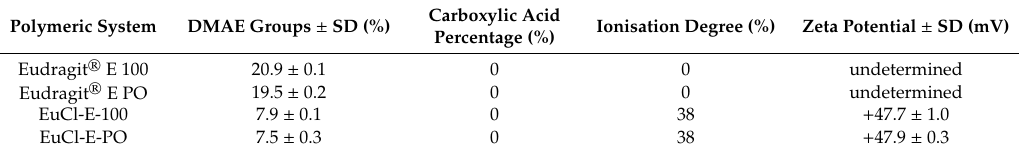
Table 1. Ionisation degree obtained for the polymeric materials derived from Eudragit E-100. Carboxylic Acid Polymeric System DMAE Groups ± SD (%) Percentage